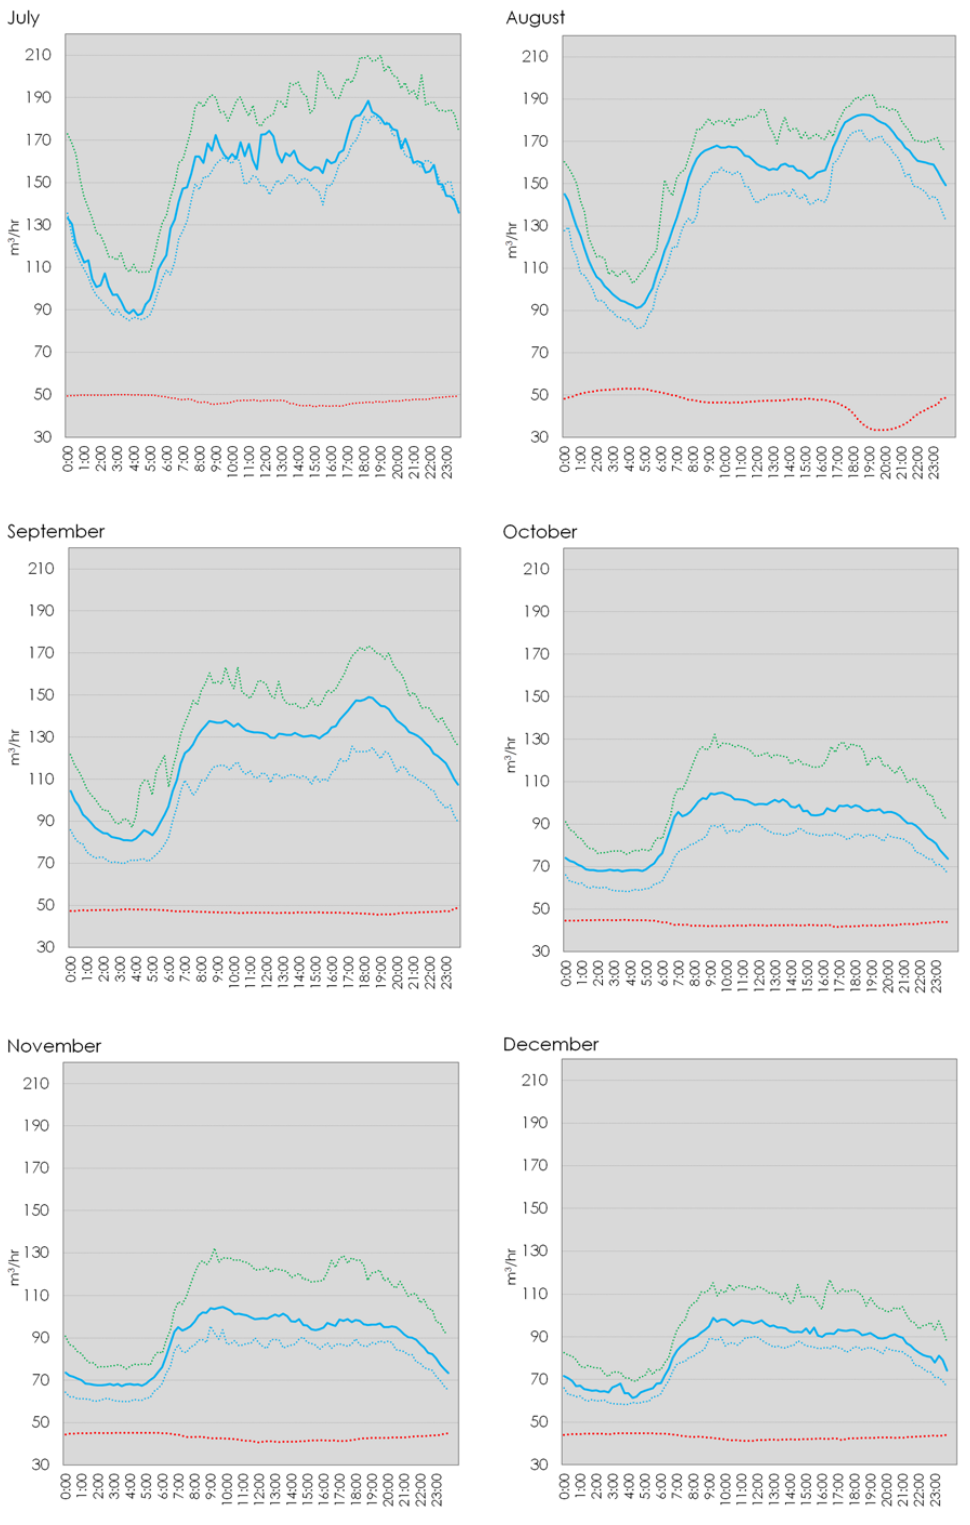
Figure 13. Flow daily patterns as estimated by average pressure-reducing valve (PRV) records (maximum recorded in green dotted line, average in blue solid line, minimum recorded in blue dotted line) and leakage as estimated through the EPANET WDN average pressure patterns at the last iteration, after apparent losses are completely decoupled from